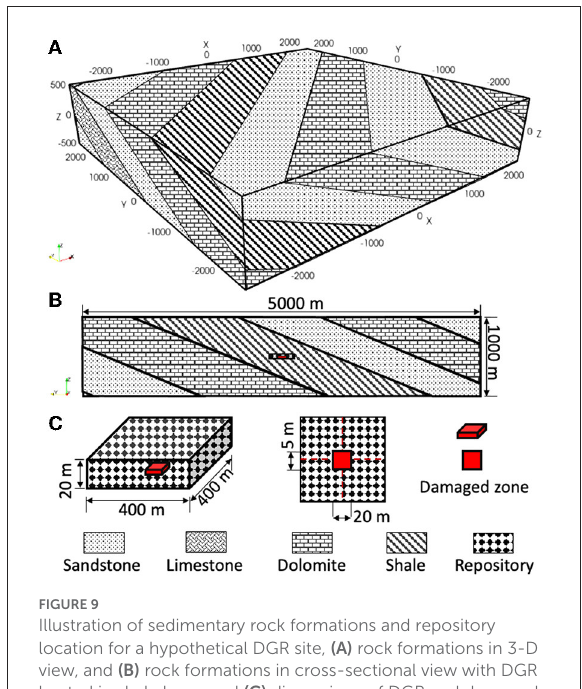
FIGURE9 Illustration of sedimentary rock formations and repository location for a hypothetical DGR site, (A) rock formations in 3-D view, and (B) rock formations in cross-sectional view with DGR hosted in shale layer, and (C) dimensions of DGR and damaged region.